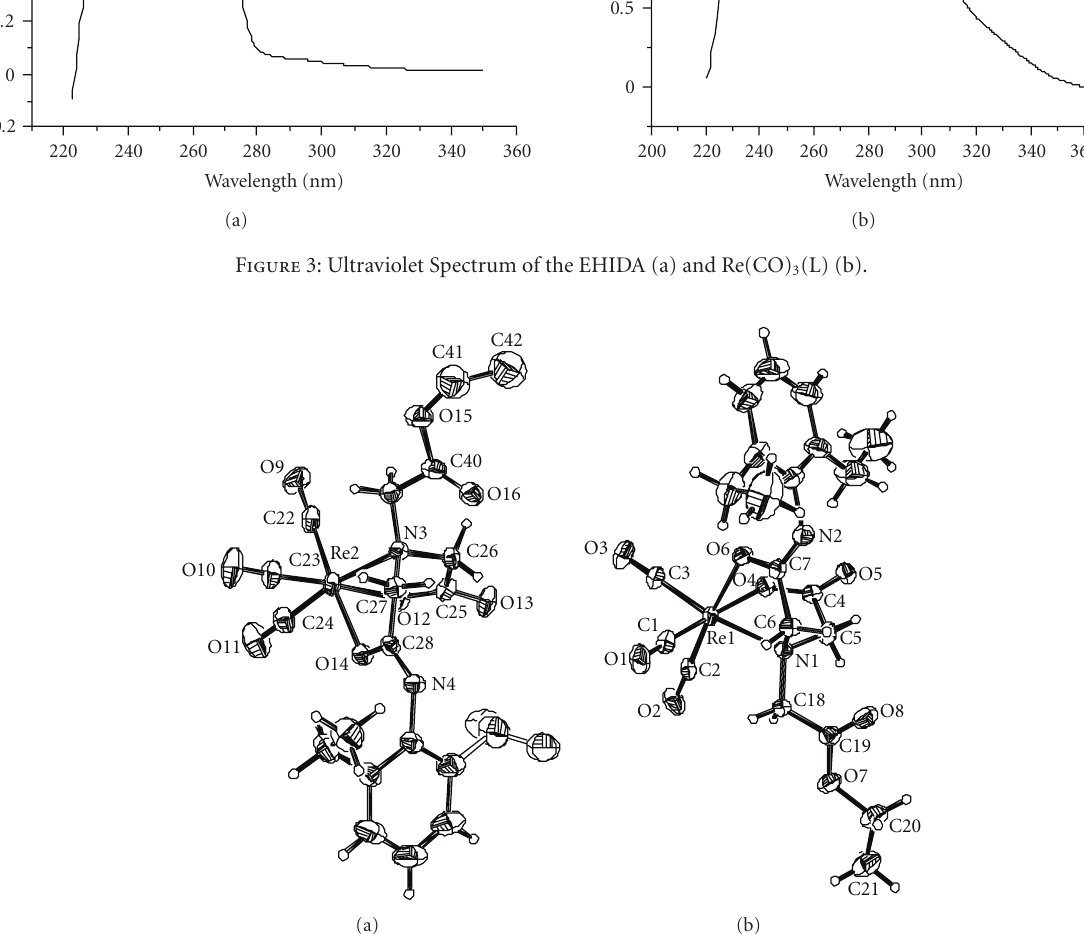
Figure 4: ORTEP drawing of the Re(CO) 3